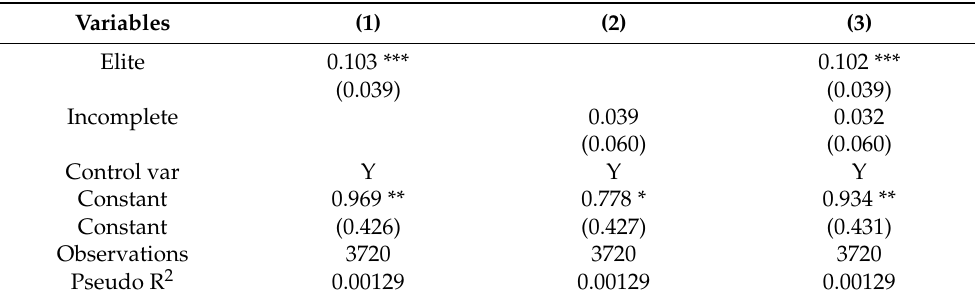
Table 4. Substitute explanatory variable metrics results.